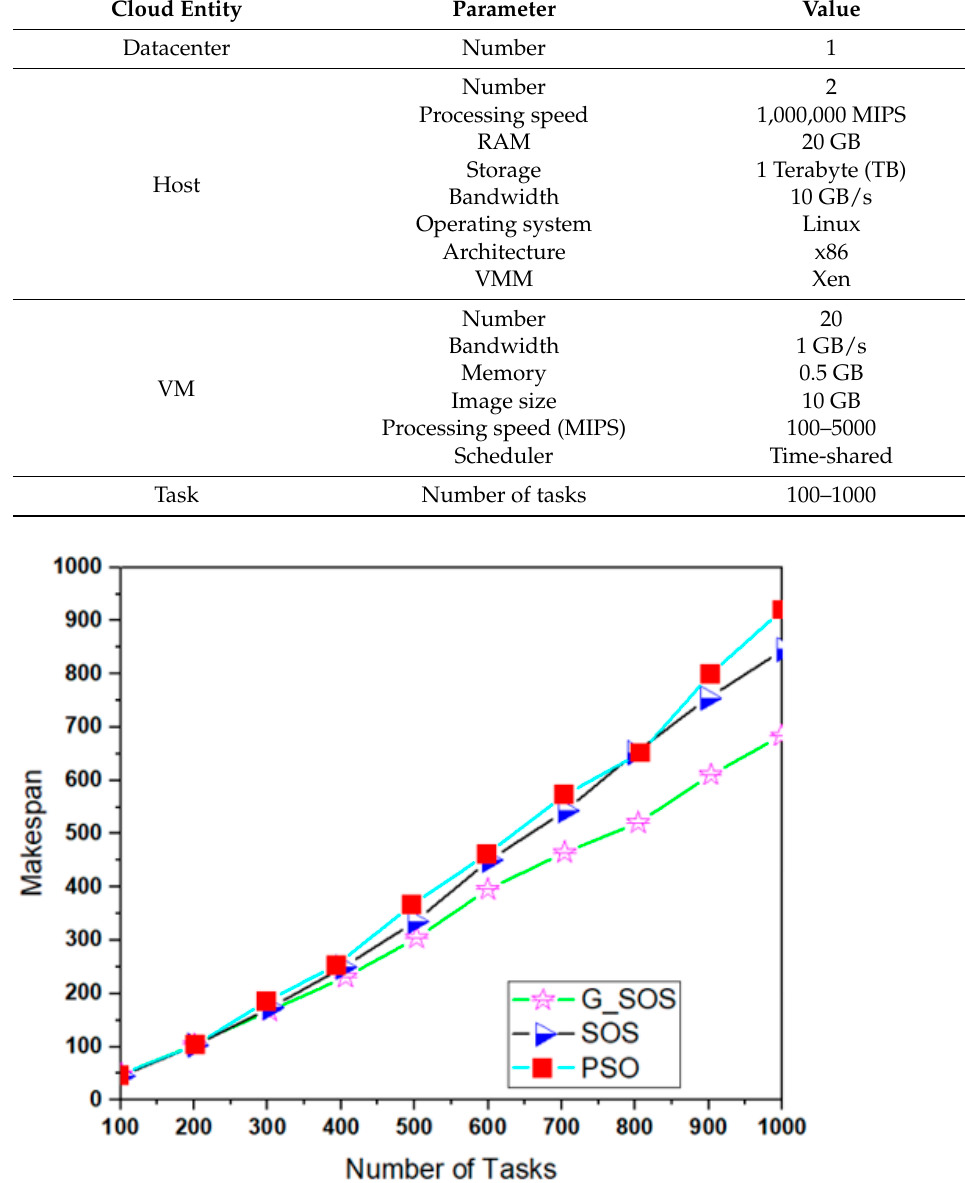
Figure 2. Makespan comparison between G_SOS, SOS and PSO (uniform distribution).